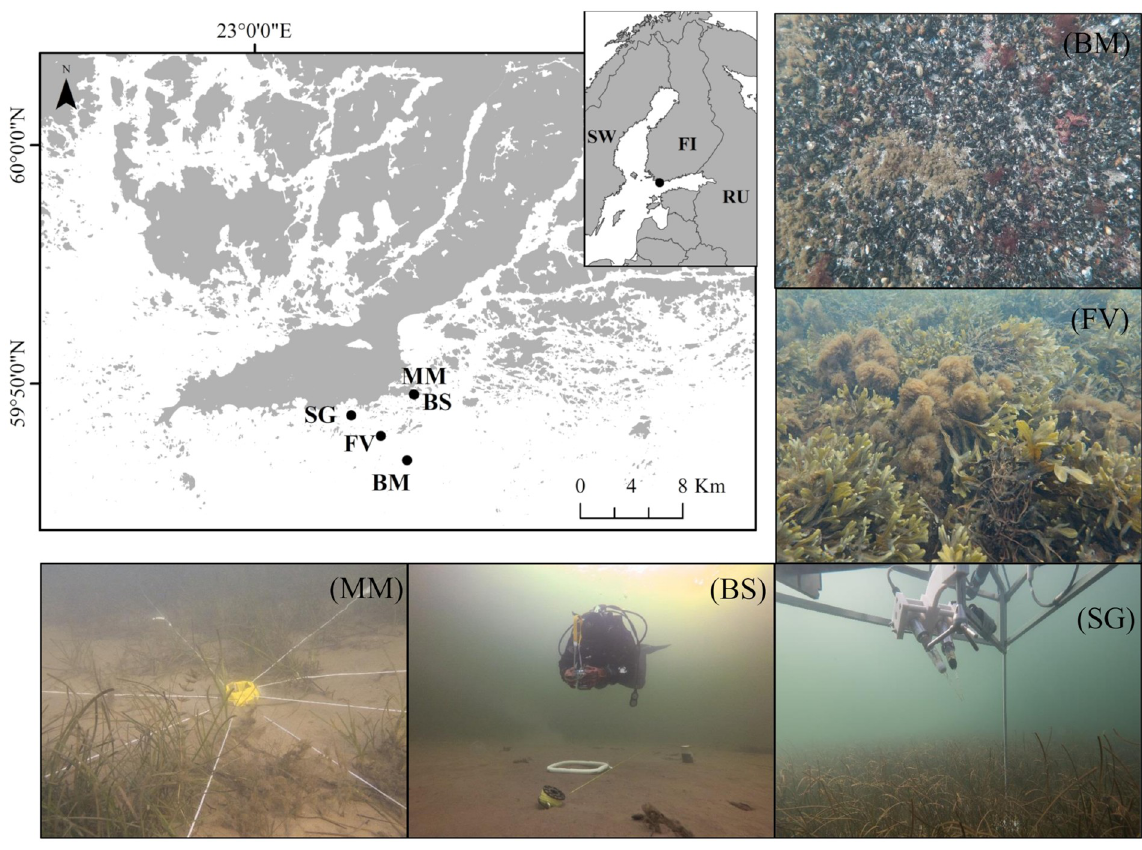
Fig 1. Map of the Baltic Sea archipelago (SW Finland) showing the locations of the habitats. Mixed macrophyte (MM) and bare sand (BS) habitats, exposed seagrass meadow (SG), littoral bladder-wrack belt (FV), and blue mussel reef (BM). A selection of photographs showing the biodiversity sampling area at the MM and BS, the AEC deployed at the SG, and a closer look to the Fucus vesiculosus and blue mussels at the BM and FV rocky beds, respectively.